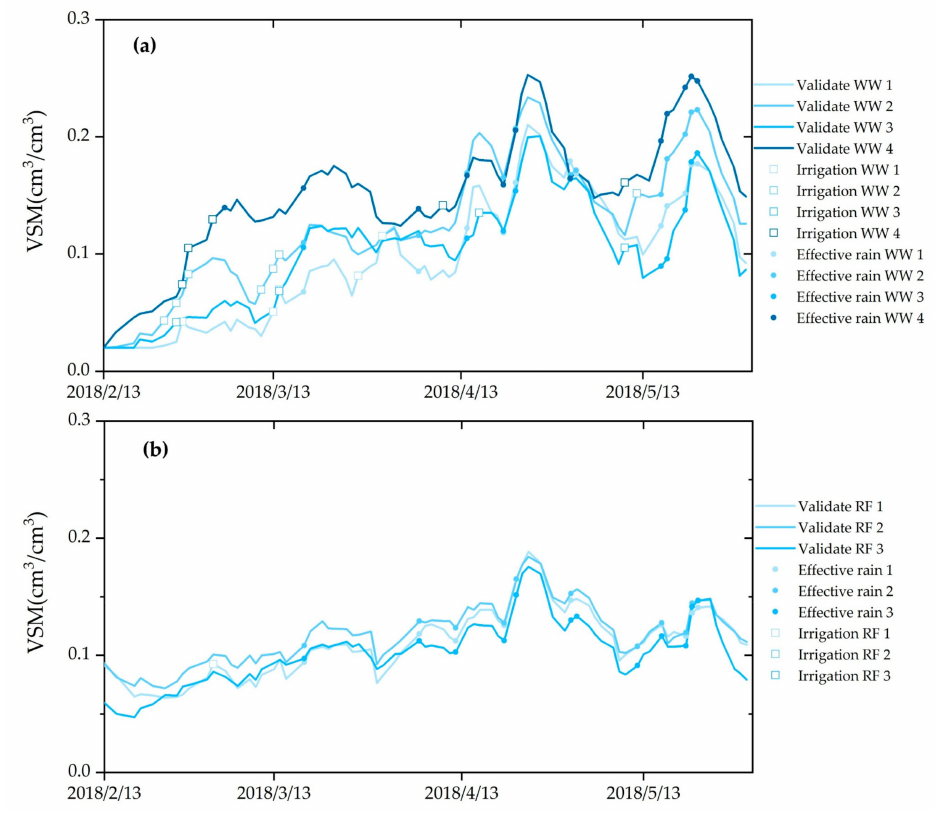
Figure 7. Irrigation signal detection results. ( a ) WW sample detection result and ( b ) RF samples detection result. The time corresponding to the square mark is the irrigation time, and the time corresponding to the circle mark is the e ff ective rain